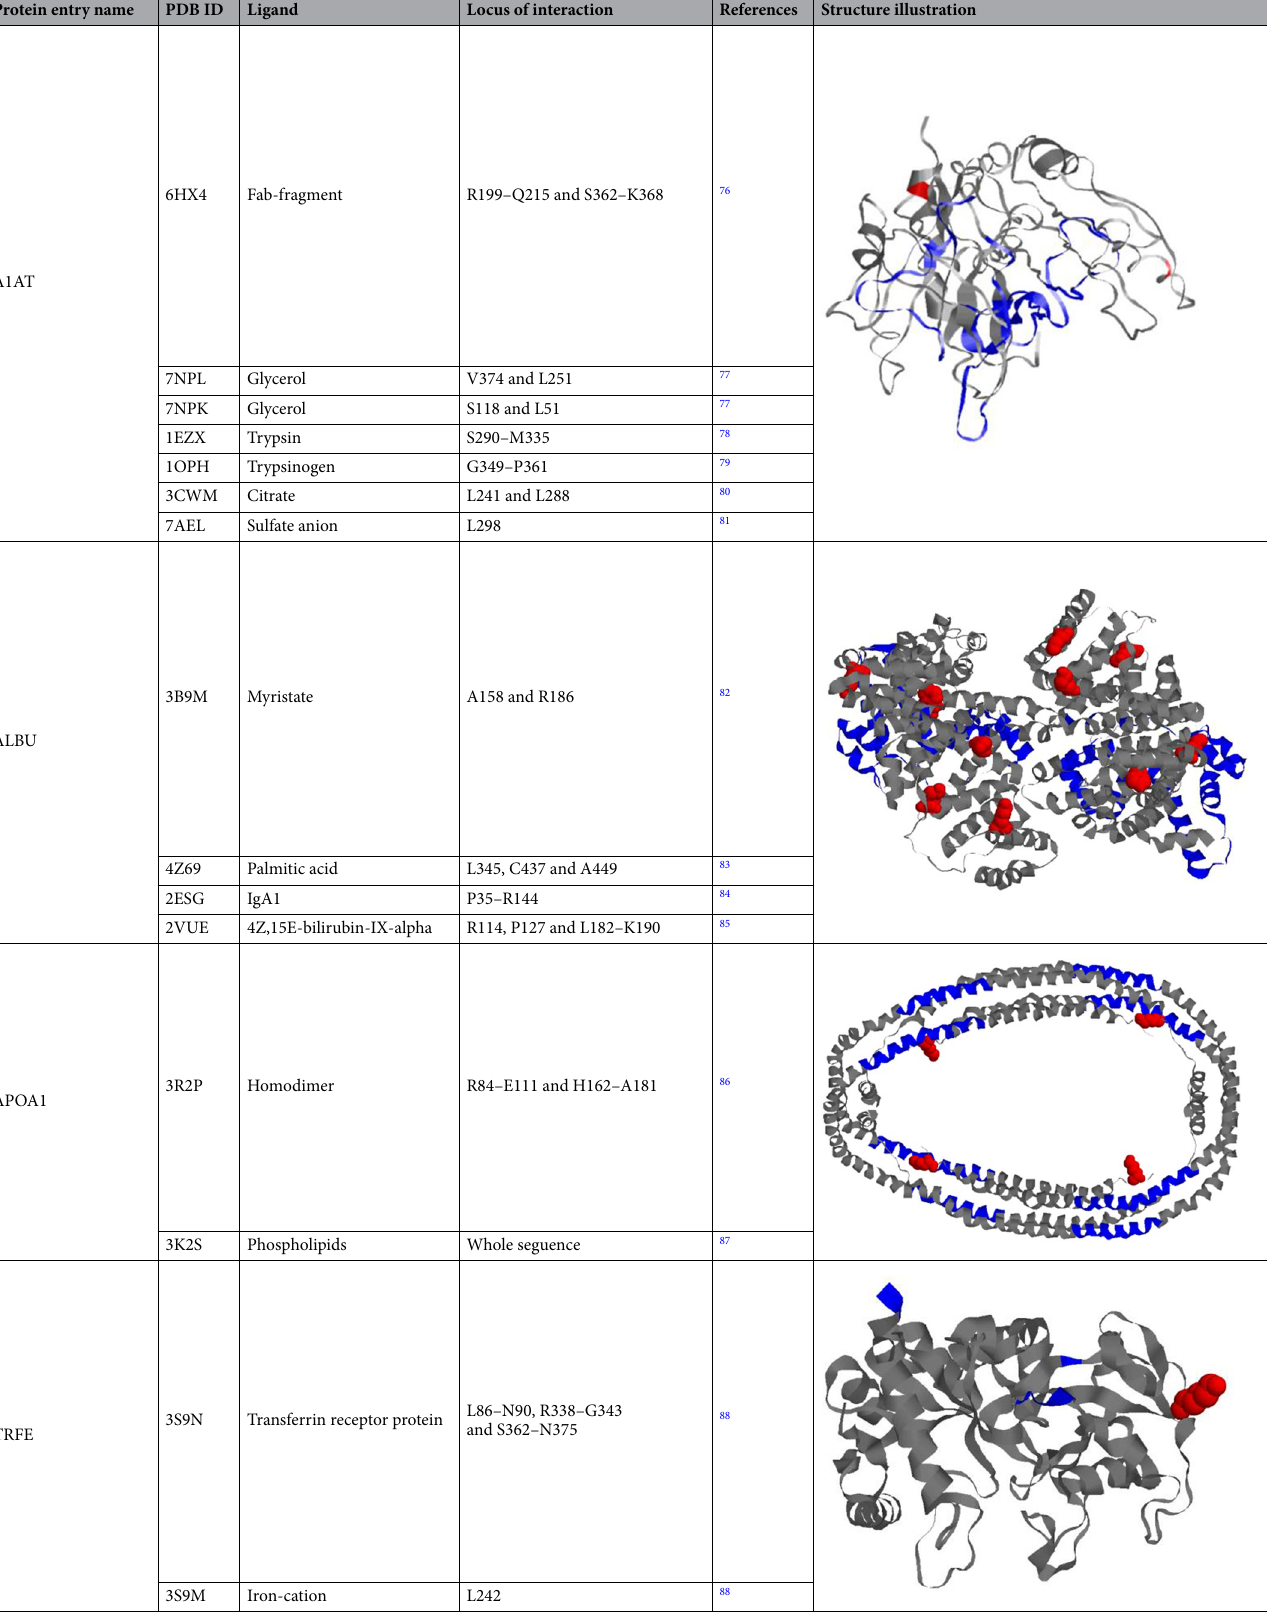
Table 4. List of known interaction sites deposited in PBD protein structures, located in close proximity to post-translationally modified amino acid residues found in patients with breast and ovaria cancer. Blue color indicates sites of interaction with ligands, red color designates amino acids with PTM found in our